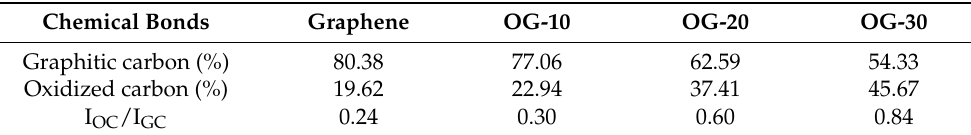
Figure 4. ( a ) XPS C 1s spectra of graphene and OG samples as a function of the H 2 SO 4 concentration. Detailed peak analyses of ( b ) graphene, ( c ) OG-10, ( d ) OG-20, and ( e ) OG-30. Table 1. Intensity ratio of the oxidized carbon and graphitic carbon (I OC /I GC ) as a function of the H 2 SO 4